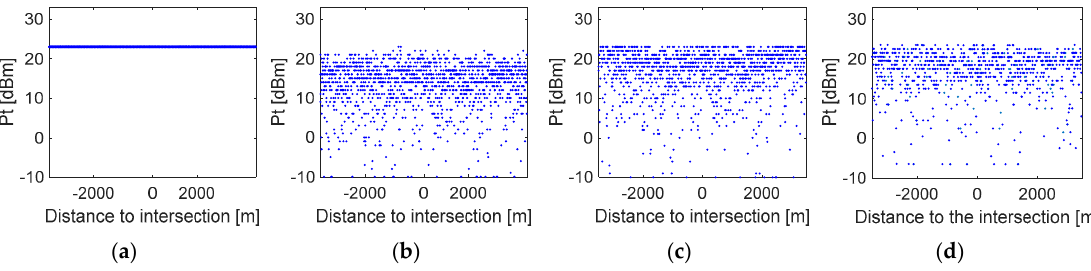
Figure 7. Snapshot of the packet transmission power used by each vehicle after 50 s of simulation time for a traffic density of 50 veh/km/lane. ( a ) A-DCC. ( b ) MINT. ( c ) INTERN. ( d ) COMPASS. Electronics 2018 , 7 , x FOR PEER REVIEW